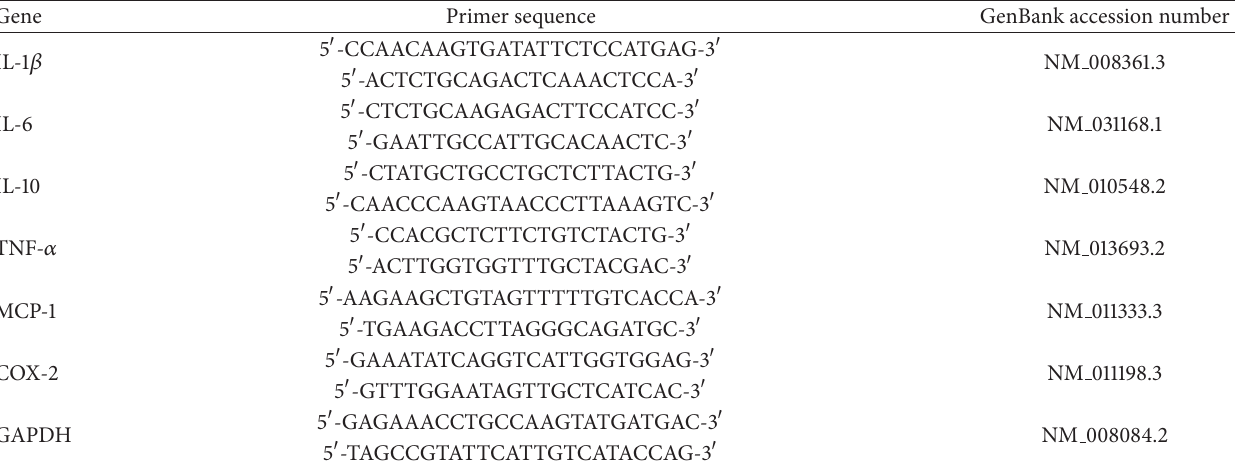
Table 1: Primers used for qRT-PCR experiments.